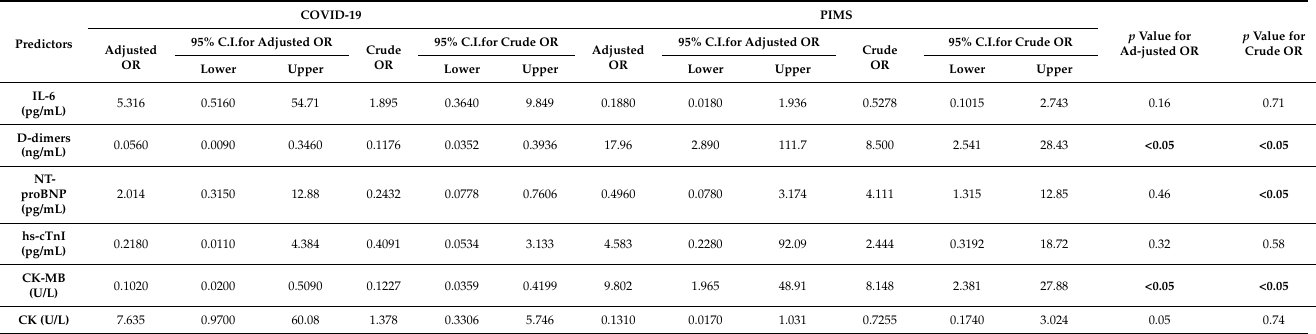
Table 6. Comparison between crude and adjusted OR.